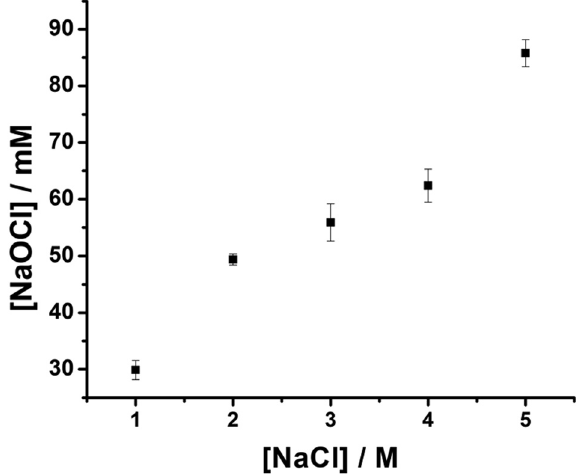
Figure 3: The in fl uence of NaCl concentration on the resulting NaOCl concentration. Electrolysis time is 60 min.